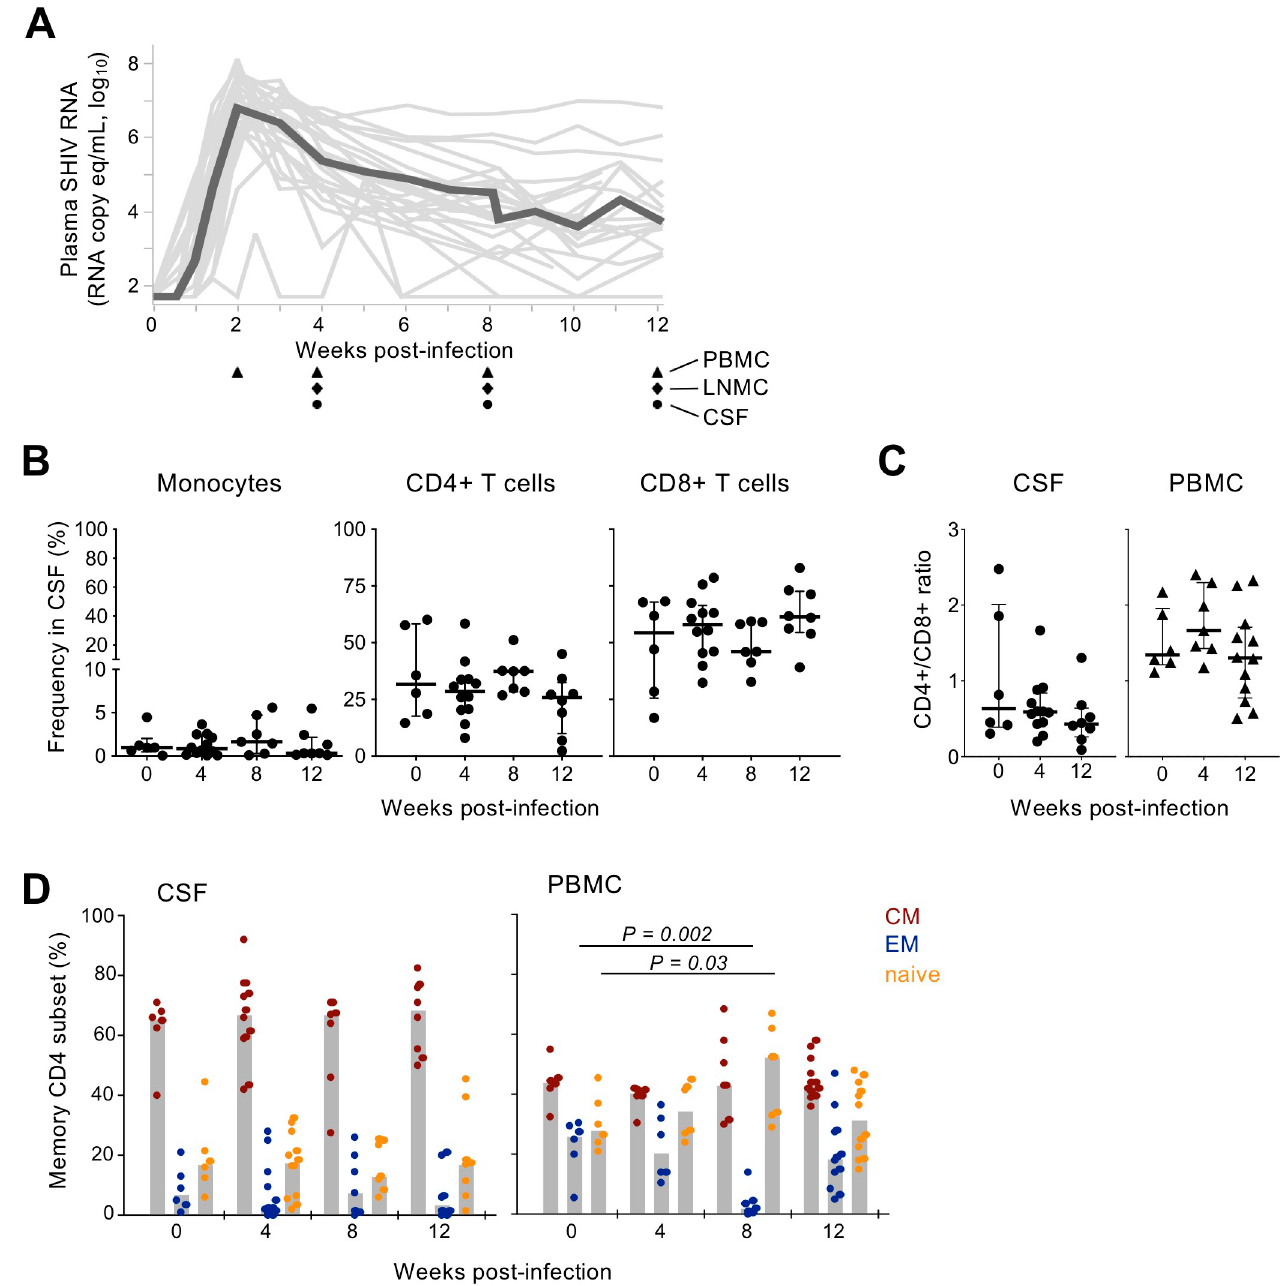
Fig 1. Plasma viremia and CSF cellular composition in acutely SHIV-infected macaques. (A) Longitudinal plasma viral RNA following SHIV-1157ipd3N4 infection in rhesus macaques (N = 18). Data for individual animals is shown in gray and the black trend line depicts the median value. Biospecimen collections are indicated by symbols at bottom. (B) The frequency of T cell subsets and monocytes in CSF determined by flow cytometry is plotted over time PI. T cell subset frequency was calculated as the percentage of all T cells; monocytes as the percentage of all viable CSF cells. (C) The CD4+/CD8+ T cell ratio in CSF (left) and PBMC (right) is shown in uninfected and SHIV-infected macaques 4 and 12 weeks PI. (D) The proportion of memory CD4+ T cell subsets in CSF (left) and PBMC (right) was assessed by CD28 and CD95 staining and flow cytometry. The frequency of central memory (CM; CD95+ and CD28+), effector memory (EM; CD95+ and CD28-negative), and naive (CD95-negative) is shown over time.